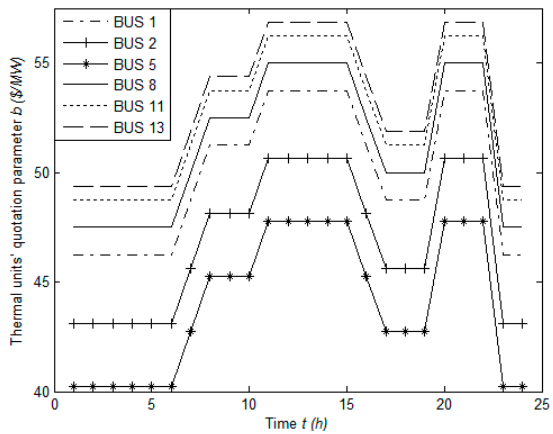
Figure 6. Thermal generators’ quotation parameter b j ( t ).